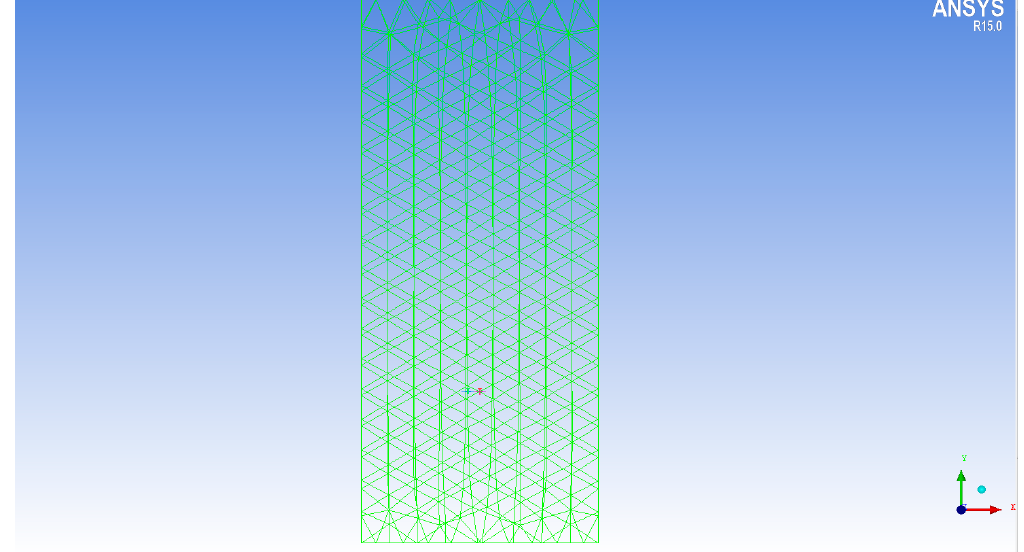
Figure 6. Wingtip-jointed aircraft system unstructured grid.